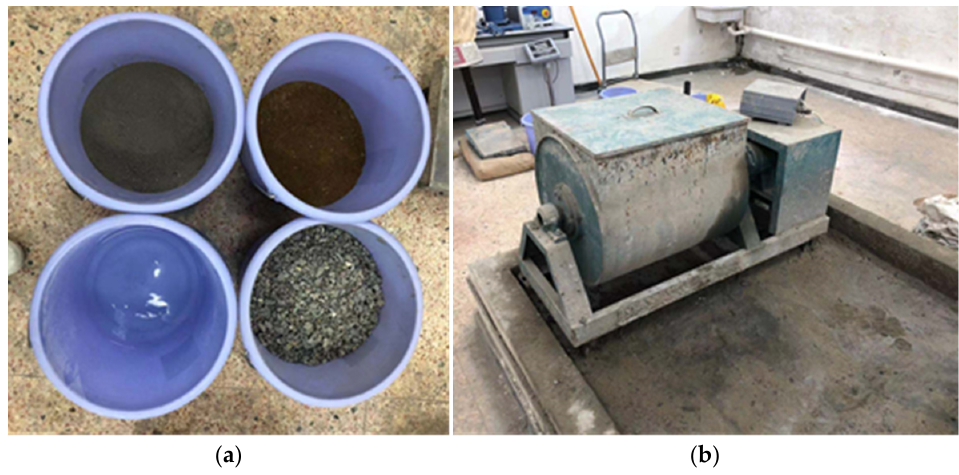
Figure 1. ( a ) Experimental materials; ( b ) Concrete mixer. Table 1. Concrete mix proportion.